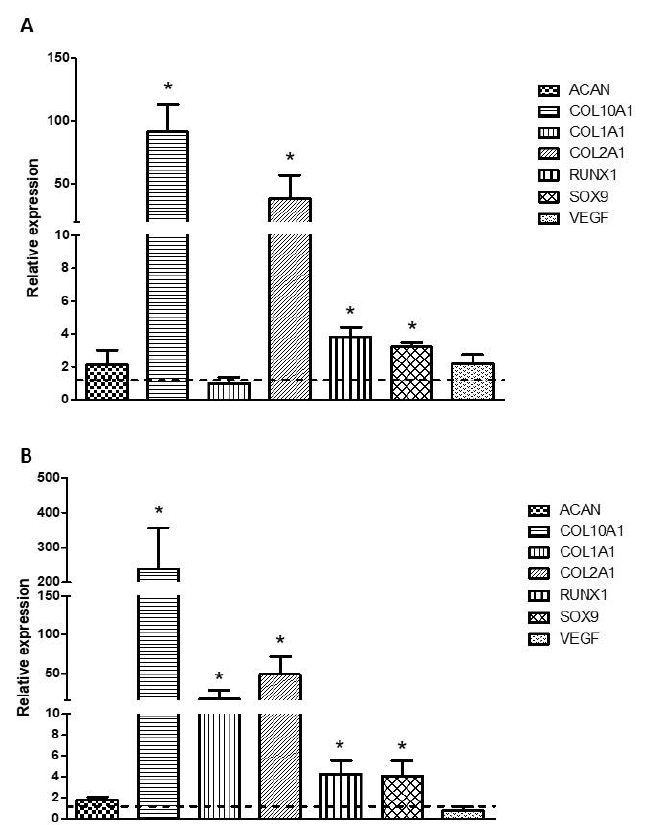
Figure 3. Chondrocyte-related gene expression levels. Human primary chondrocytes ( A ) or hDPSCs ( B ) were cultured with proliferation or differentiation medium for 4 weeks. The relative levels of gene expression of ACAN, COL10A1, COL1A1, COL2A1, ACAN, RUNX1, SOX9 and VEGF were evaluated by real-time RT-PCR. GAPDH was used as house-keeping gene. The fold change (2-∆∆Ct) was calculated using the relative expression of cells cultured with proliferation medium as a control group (indicated by the dotted line). Mean ± SD of three different experiments is represented. * p < 0.05 compared to control group. Human primary chondrocytes and hDPSCs were encapsulated in scaffolds of 3% al- ginate-1% agarose. To encapsulate cells, they were suspended in a 6% alginate solution at a density of 2 × 10 6 cells/mL. The same volume of a 2% agarose solution was added, and a